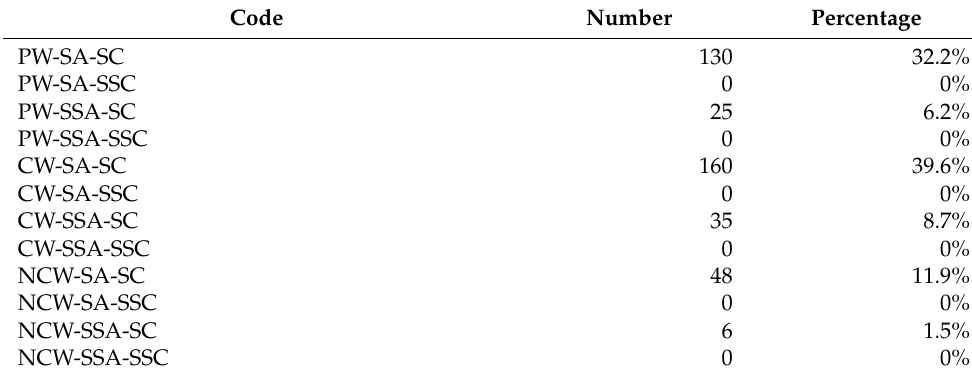
Table 8. Improvement in production and